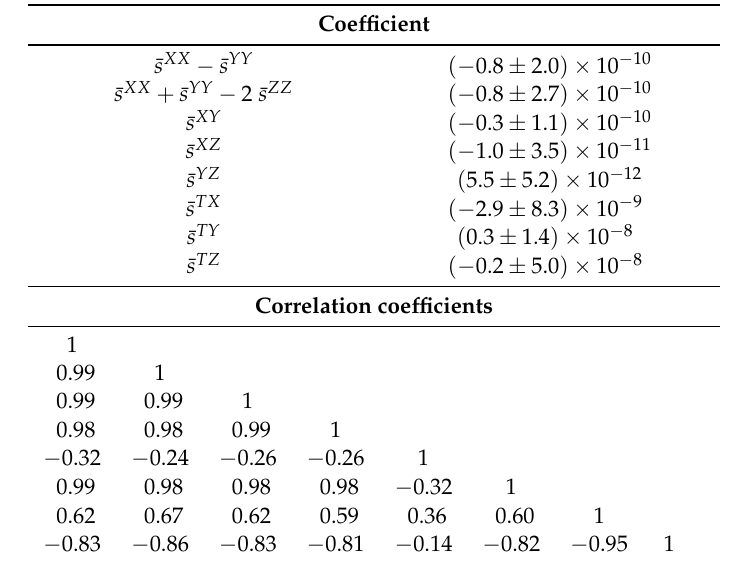
Table 4. Estimations of the SME coefficients from a postfit data analysis based on planetary ephemerides from [50]. The uncertainties correspond to the 68% Bayesian confidence levels of the marginal posterior probability distribution function. The associated correlation coefficients can be found in Table III from